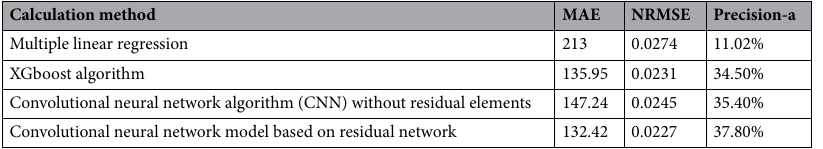
Table 2. Comparison of evaluation indexes of simulation results of various algorithms. Source Author made.